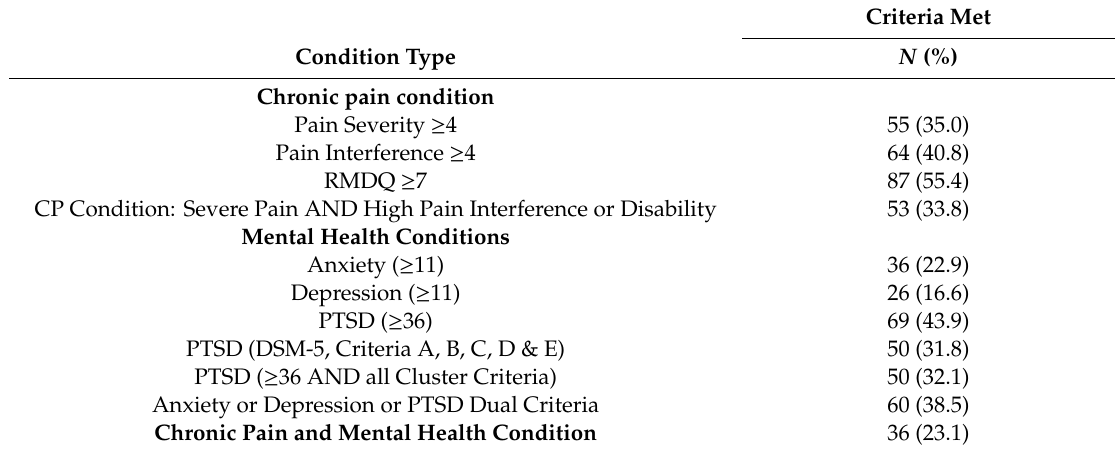
Table 3. Prevalence of Pain, Pain Disability and Mental Health Condition